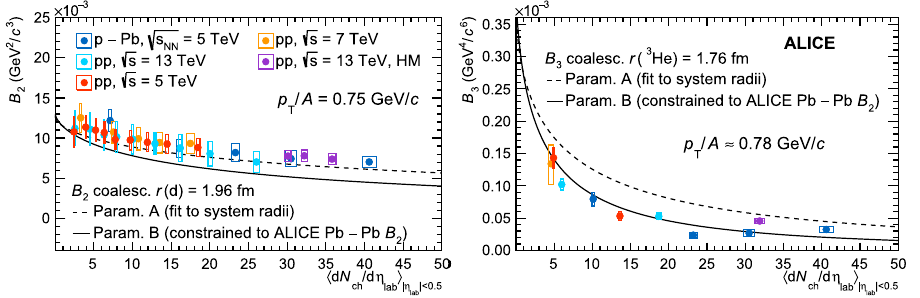
√ √ s = 13 TeV [24] and at s = 7 TeV [6], and in pp collisions at √ √ s = 13 TeV s NN = 5 . 02 TeV [31]. The statistical uncertain- p–Pb collisions at √ √ s = 13TeV[23]andat s = 7TeV ties are represented by vertical bars while the systematic uncertainties √ s NN = 5 . 02 TeV [11]. Right: B 3 as a are represented by boxes. The two lines are theoretical predictions of √ s = 5 . 02 TeV, the coalescence model based on two different parameterisations of the √ s = 13 TeV [24], in INEL > 0 system radius as a function of multiplicity